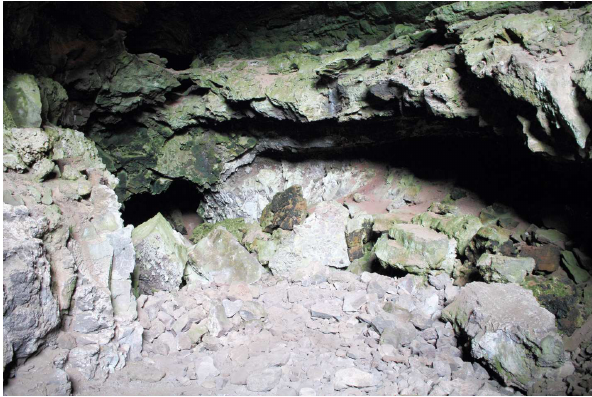
Figure 1. Photo of the La Corona lavatube on Lanzarote at